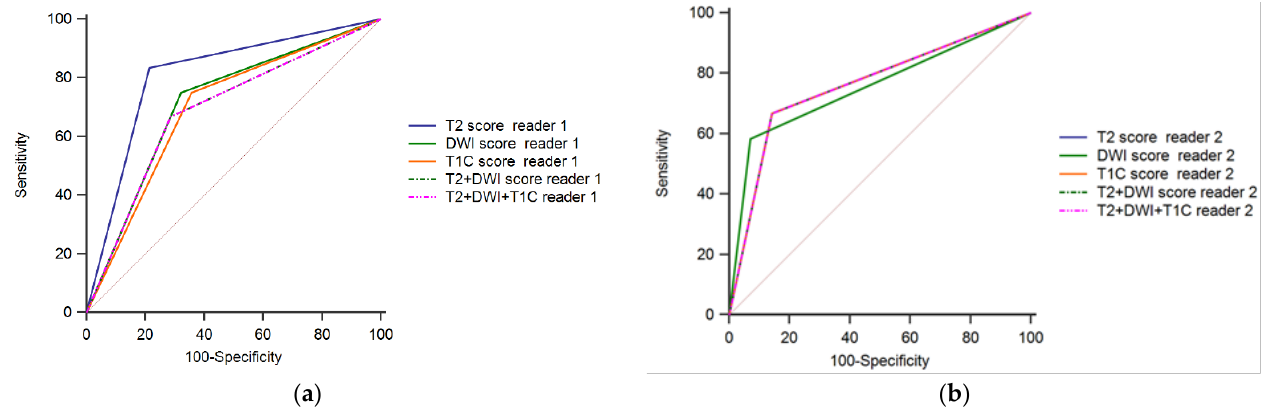
Figure 6. Receiver operating characteristics for the detection of near-complete response (Reader 1 — panel ( a ); Reader 2 — panel ( b )).